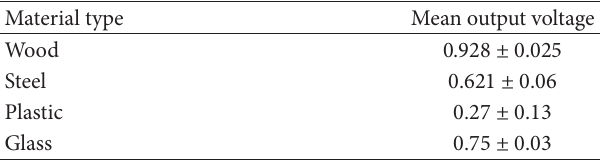
Table 2: Mean output voltage of the selected material.